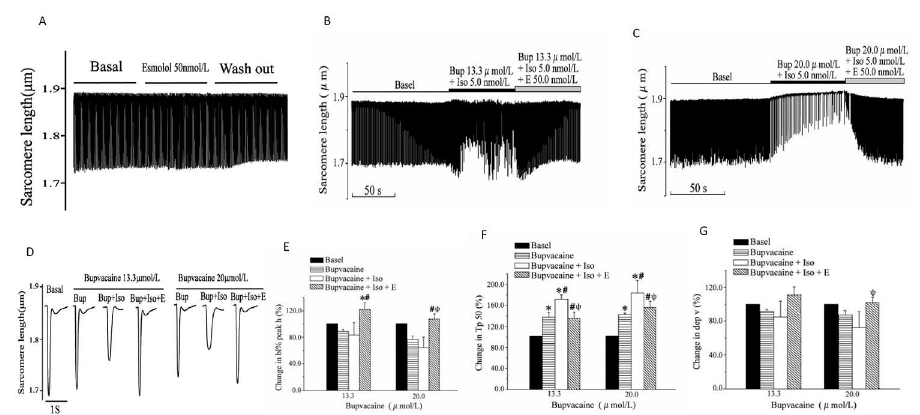
Fig 5. Isoprenalin aggravated bupivacaine-induced myocardial dysfunction, and esmolol inhibited the aggravation. (A) Representative sarcomere-shortening trace before and after exposure to esmolol. (B) and (C) Representative sarcomere-shortening trace perfused with bupivacaine in the presence or absence of bupivacaine + isoprenalin, with or without esmolol, in succession. (D) Averaging ten successive signals of (B) and (C). (E), (F) and (G) Effect of esmolol, isoprenalin and bupivacaine on bl% peak h, Tp50 and dep v. Data are the mean ± SD. (cid:3) P < 0.05, vs . basal amplitude. † P < 0.05, vs . bupivacaine; ‡ P < 0.05, vs . bupivacaine + isoprenalin.